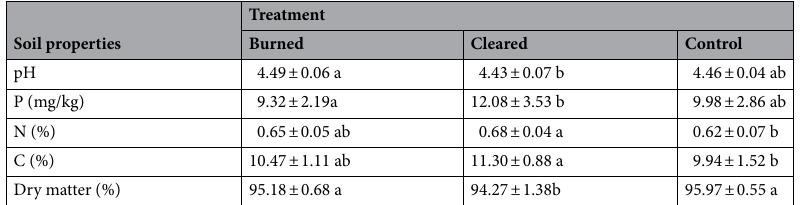
Table 3. Mean physicochemical properties of soil samples collected 9 years after scrublands were subjected to prescribed burning or clearing (mechanical shredding) treatments. *Different lowercase letters indicate significantly different mean values ( p <